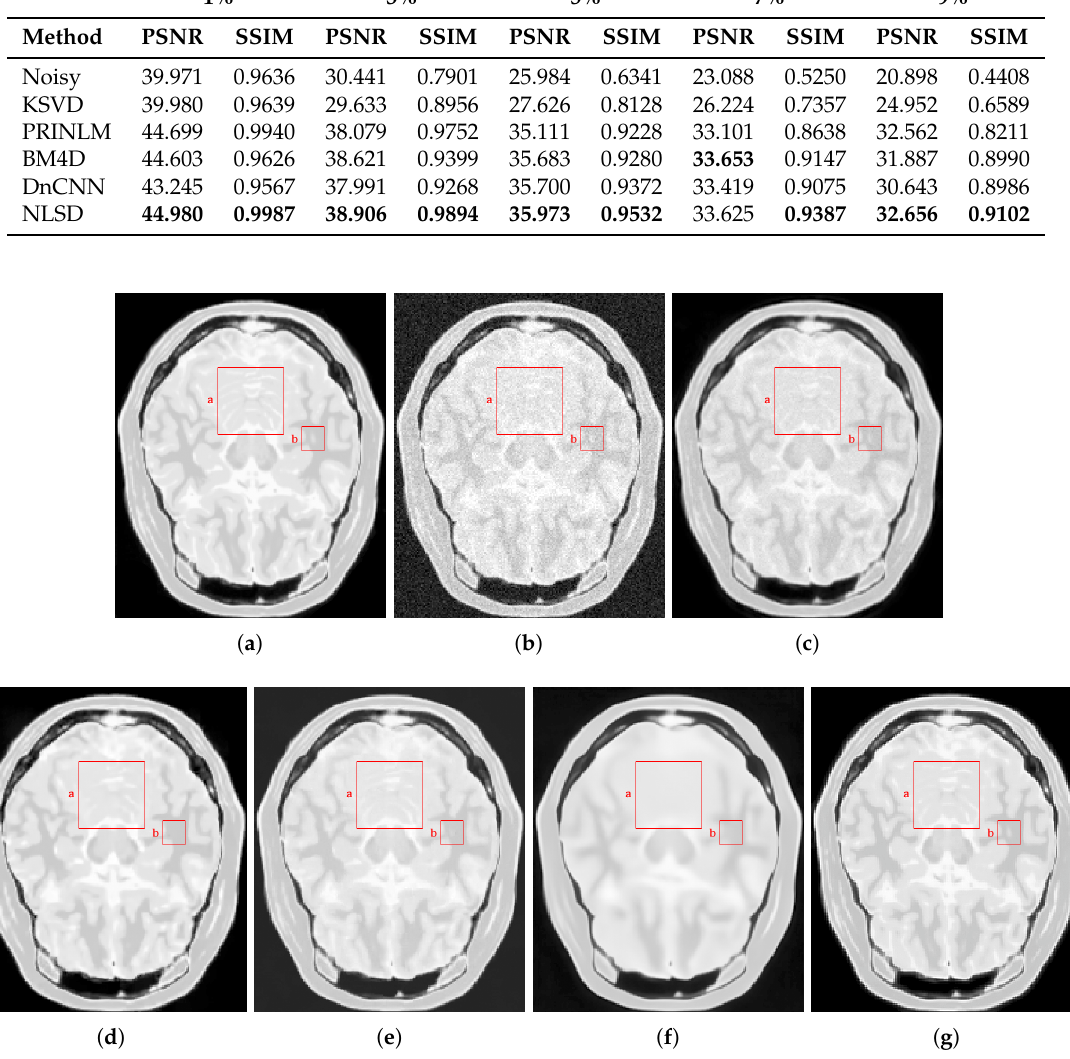
Figure 15. Comparison of the denoising methods on the PDw synthetic noise-free MR image corrupted with 5% Rician noise. ( a ) Original synthetic noise-free MR image. ( b ) Original image corrupted with 5% Rician noise. ( c – g ) are the denoising results of the KSVD, the PRINLM, the BM4D, the DnCNN and the NLSD,